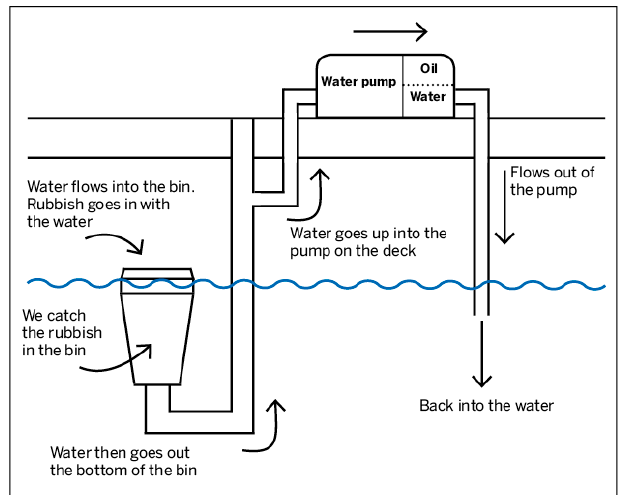
Figure 3. Seabin working principle. Source: www.seabinproject.com (Accessed on 02 nd March 2022).